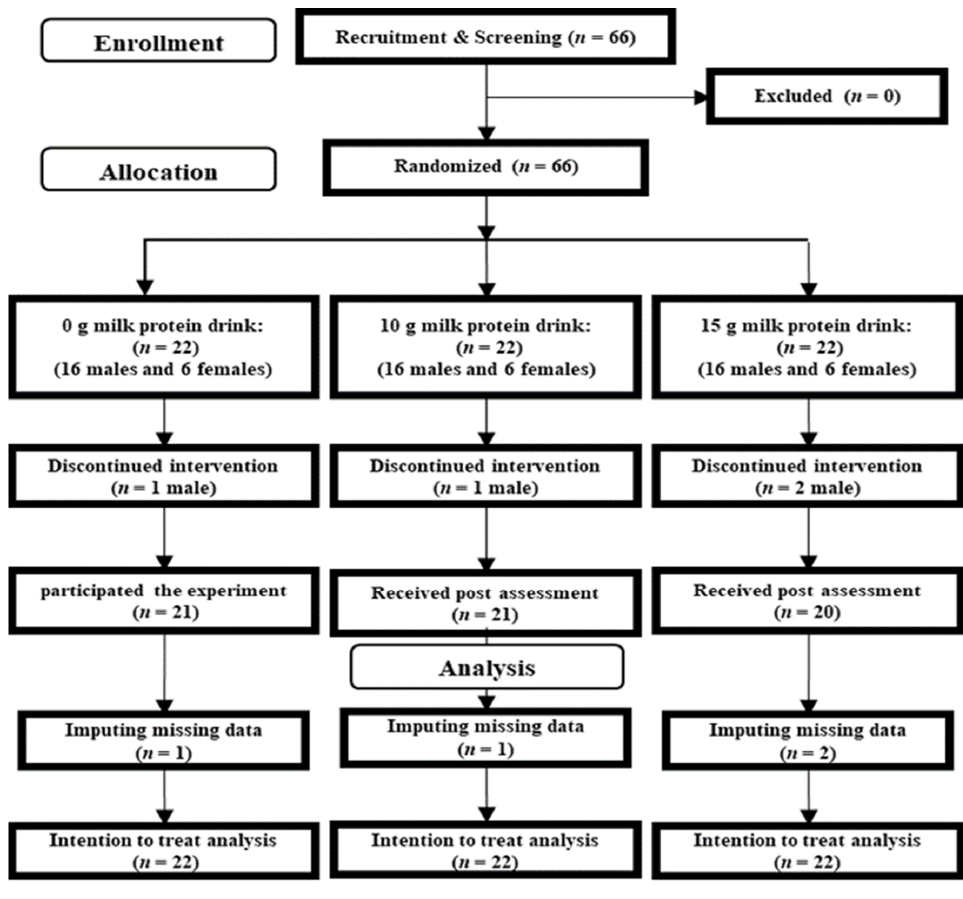
Figure 1. CONSORT diagram. Table 1. Characteristics of participants. Table 1. Characteristics of